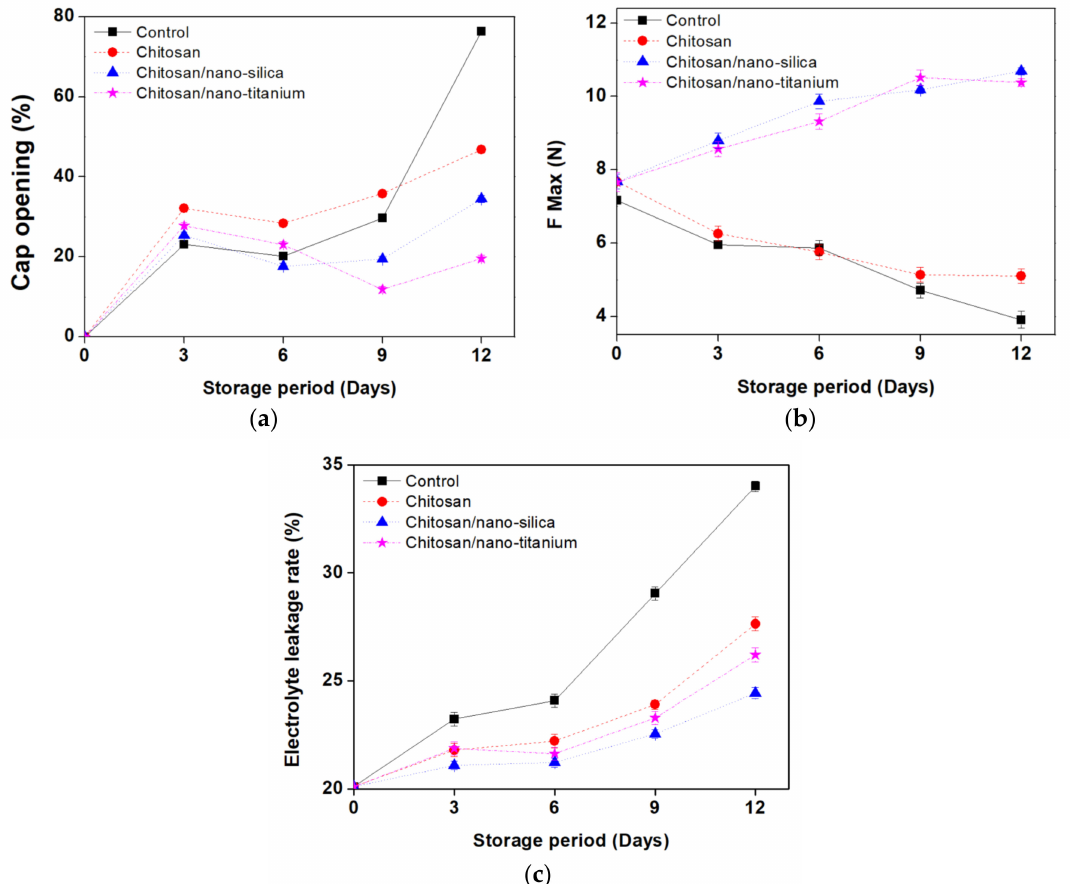
Figure 3. Effects of nano-films on cap opening ( a ), F Max ( b ), and electrolyte leakage rate ( c ) for white button mushrooms during storage at 4 ◦ C for 12 days. Data are mean ± SD, n =